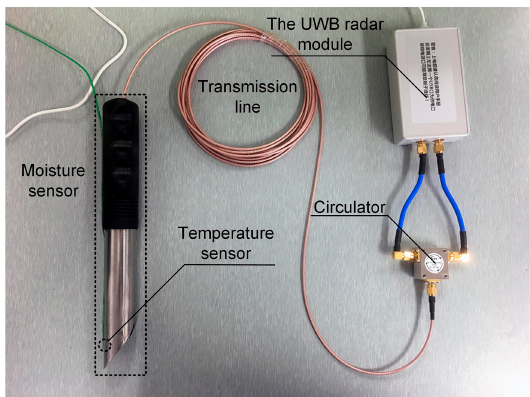
Figure 8. Summary diagram of the proposed moisture content measuring method.